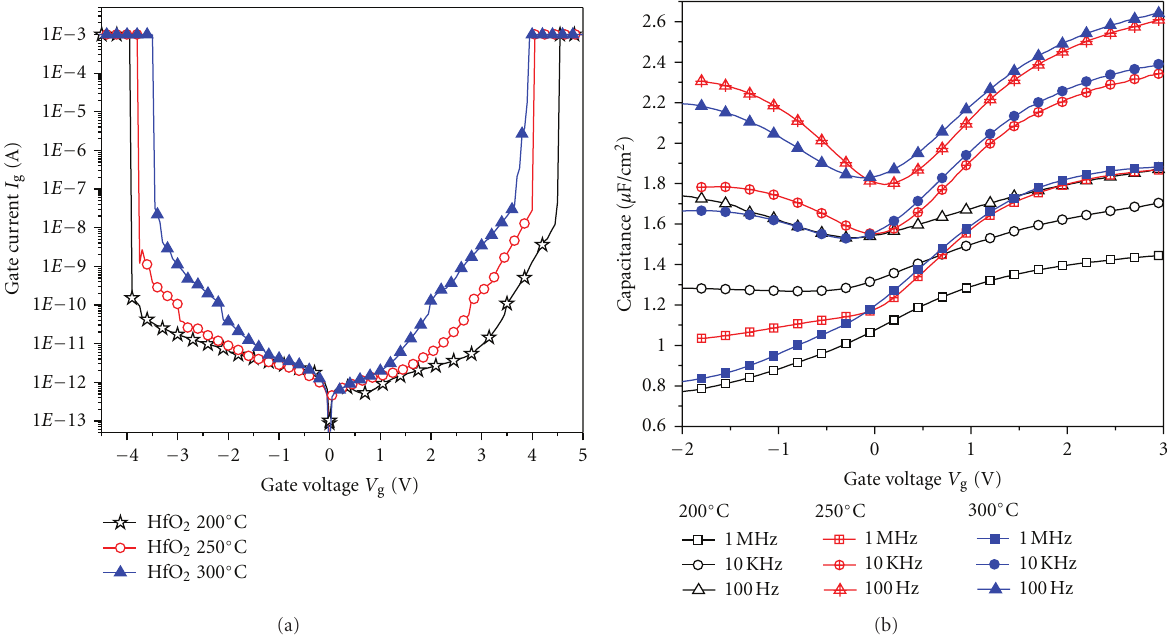
Figure 4: (a) I - V and (b) frequency-dependent C - V characteristics of Pt/HfO 2 /InP/InAs MOS capacitors in which HfO 2 was deposited at 200, 250, and 300 ◦ C,